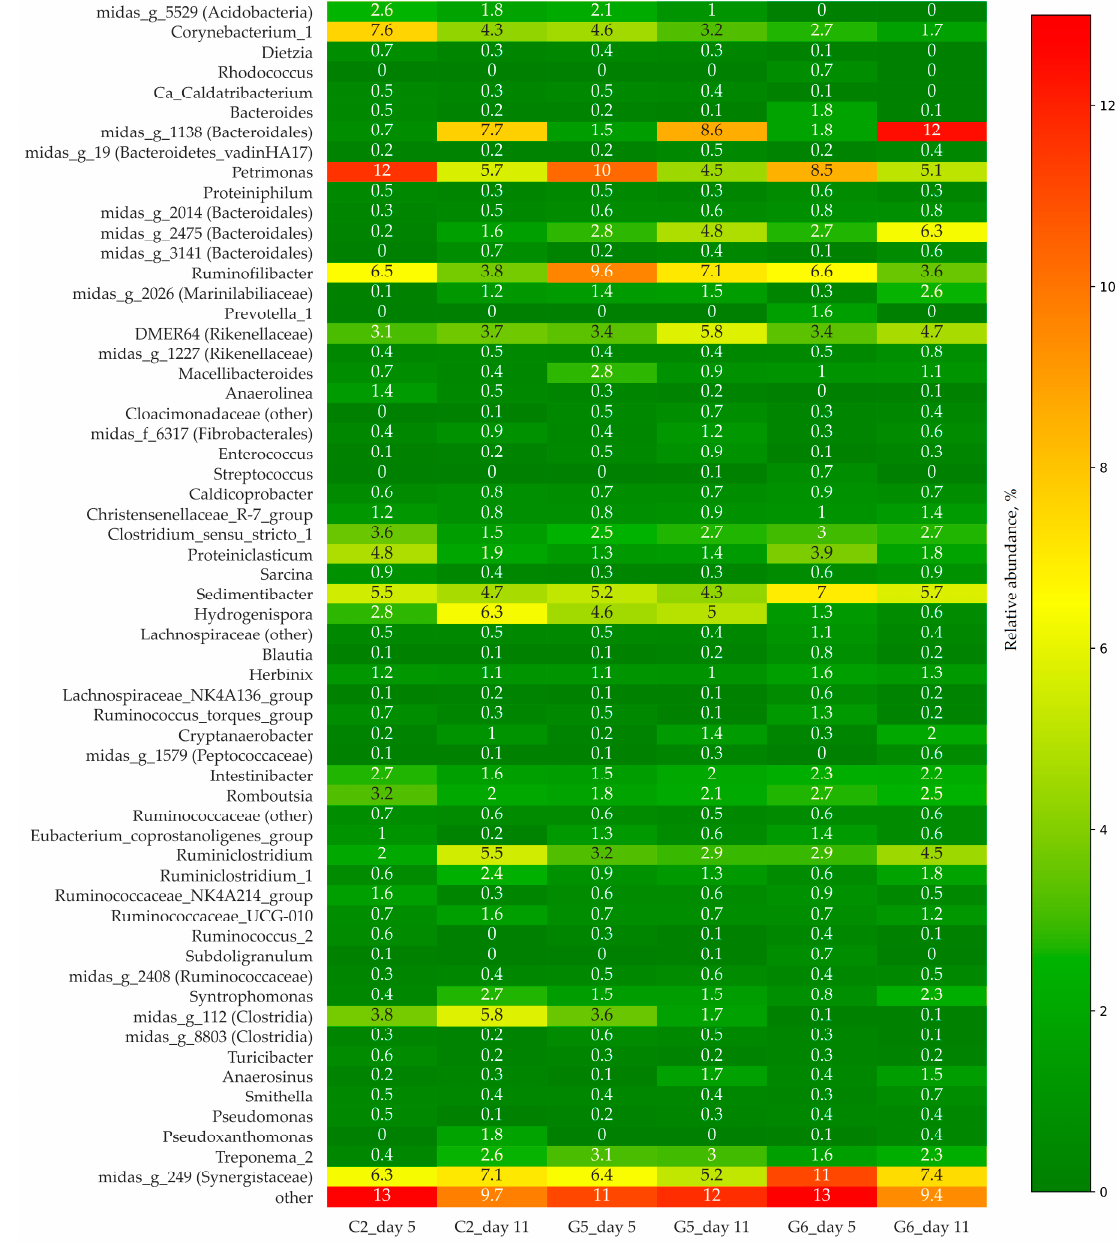
Figure 6. Heatmap illustrating the relative abundances of bacterial taxa in reactors C2, G5, and G6 (sampled on days 5 and 11). Bacterial community composition according to amplicon sequencing of the bacterial 16S rRNA gene is shown on the genus level. Only taxa comprising at least 1% relative abundance in at least one sample are presented.